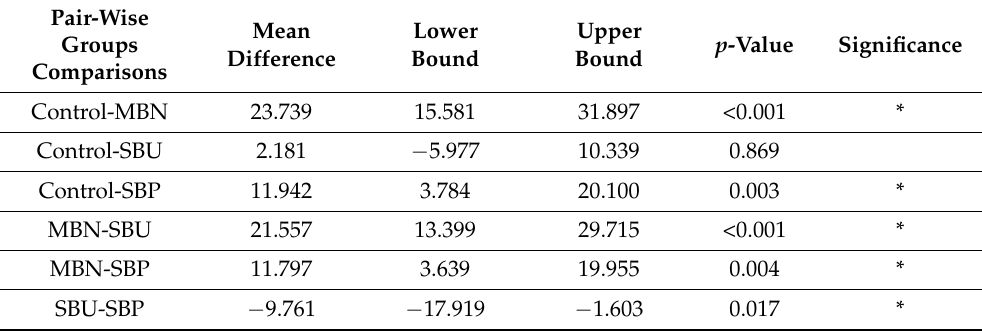
Figure 2. The means ± standard deviations (SDs) of resin-ceramic microtensile bond strength ( µ TBS) (expressed in MPa) of Group 1 (control), no priming; Group 2, primed with MBN; Group 3, primed with SBU; and Group 4, primed with SBP. Different superscript letters indicate statistically significant difference ( p < 0.05) between groups. Table 2. Results of Tukey’s multiple comparisons statistical analysis of μ TBS data.